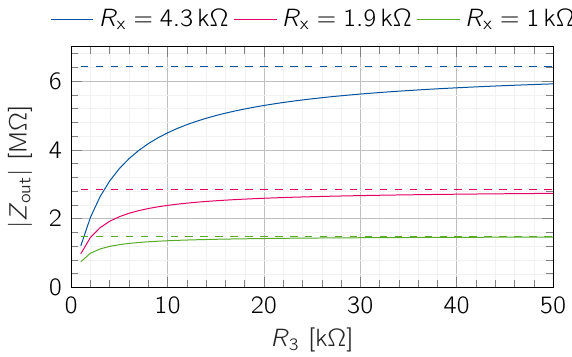
Figure 2: Theoretical EHCS output impedance for R x = 1 k (cid:10) , 1 : 9 k (cid:10) and 4 : 3 k (cid:10) over R 3 . Z shows asymptotic behavior. Larger R x require bigger R 3 to maximize the possible Z out . asymptotic behavior of Z out for three exemplary R x over R 3 .